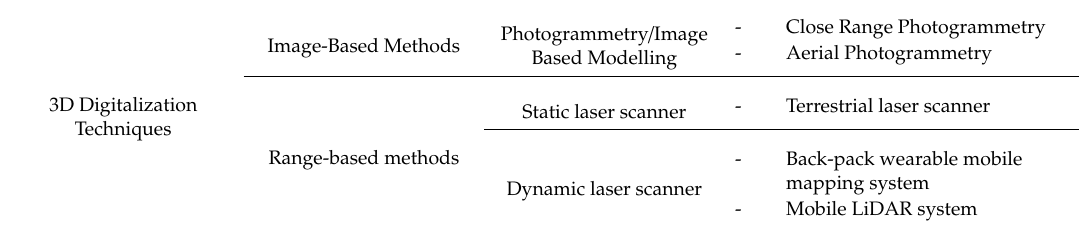
Table 1. Remote sensing approaches used for the characterization of rock